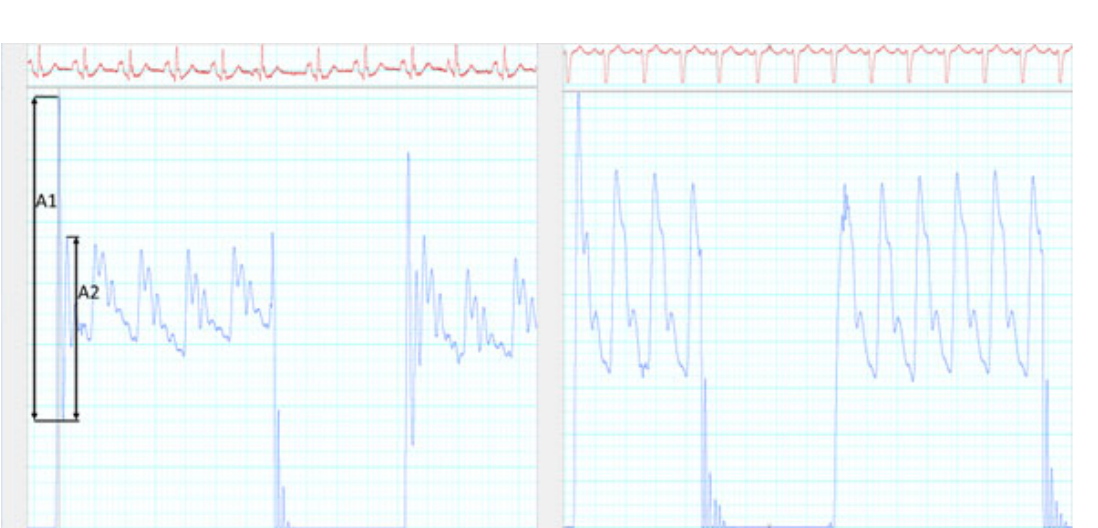
Figure 2. Measurement of the natural frequency and the damping coefficient during a fast flush test on the fluid ‐ filled arterial line on the left panel. The right panel shows a much better frequency response and optimal damping without oscillation on the recording with an FFR wire in another patient. A1 is the amplitude of the first peak, A2 the amplitude of the second one.